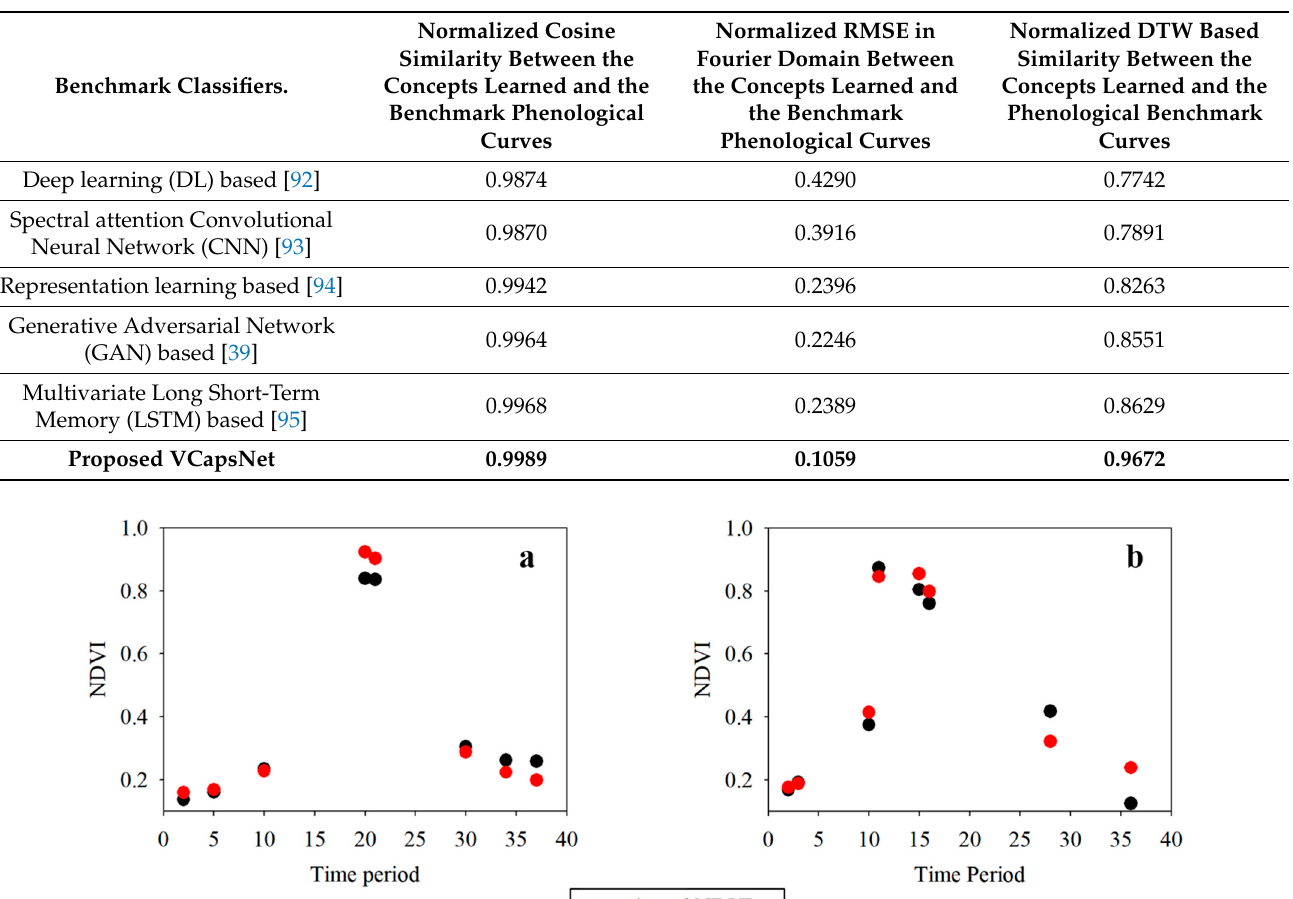
Table 4. Interpretability based comparison of the different deep learning (DL) models. Benchmark Classifiers.